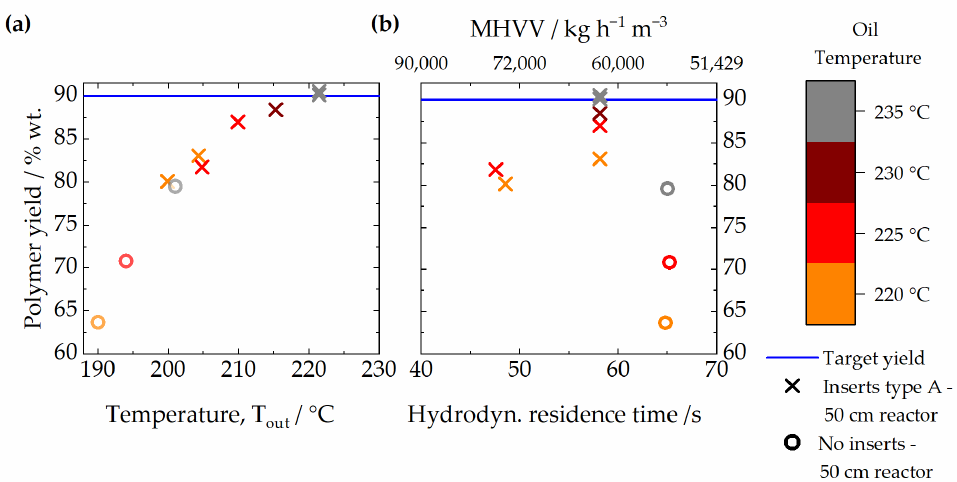
Figure 8. Comparison of the polymer yield versus ( a ) temperature at the reactor outlet and ( b ) hydrodynamic residence time, using internals type A and no internals (empty reactor) in a 50 cm reactor, for 60% wt. glucose in feed, with mass flow rate 3.15 ± 0.05 kg h − 1 and pressure in the range of 2 ± 0.3 bar. The MHHV is also indicated in the graph. The color scale represents oil set temperatures.